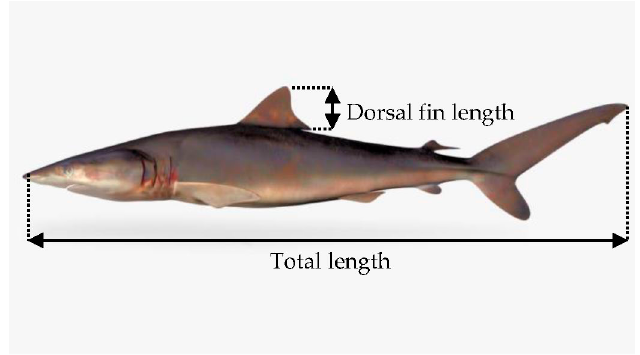
Figure 4. Silky shark ( Carcharhinus falciformis ).